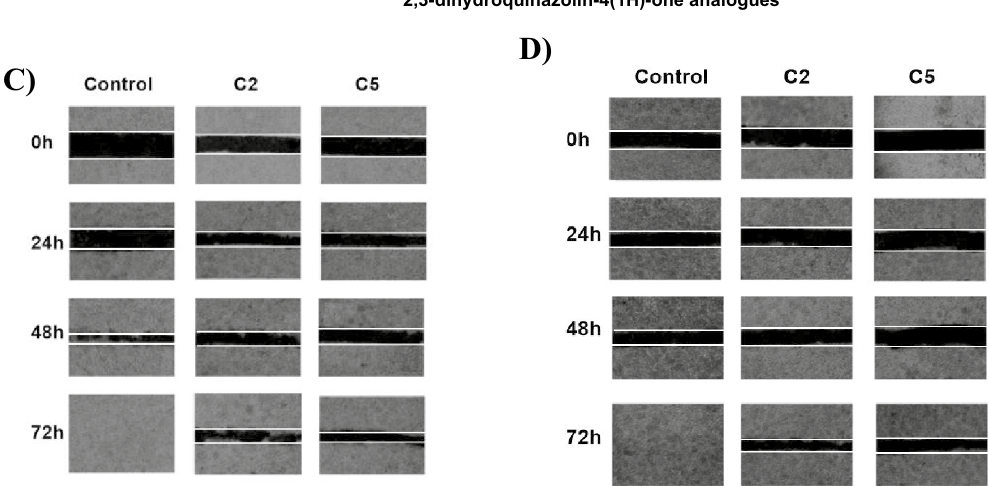
Figure 3. Effect of the seven 2,3-dihydroquinazolin-4(1 H )-one analogues (C1–C7) on the migration of PC3 and DU145 prostate cancer cell line. Wound healing assay presented as % of wound closure after 24 h, 48 h and 72 h treatment compared to control untreated cells in ( A ) PC3 and ( B ) DU145 cell lines. Effect of C2 and C5 on wound in PC3 ( C ) and DU145 ( D ) cell lines well at time 0 h, 24 h 48 h and 72 h. Data in A and B are shown as mean ± SD of triplicates compared with the untreated control. One-way ANOVA analysis using Tukey’s post hoc test was used to indicate significance. * P -value ≤ 0.05, ** P -value ≤ 0.01, *** P -value ≤ 0.001, **** P -value ≤ 0.0001 compared to